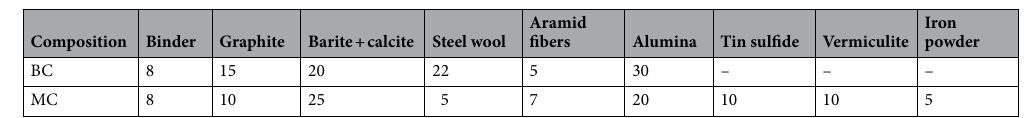
Table 1. BC and MC composition (in